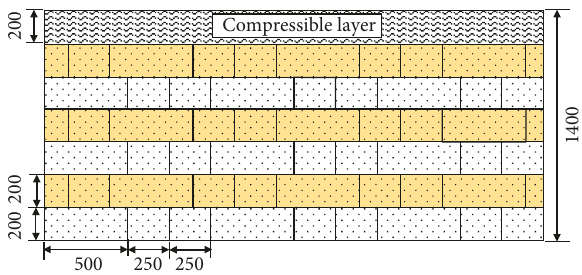
Figure 11: Diagram of the block wall.